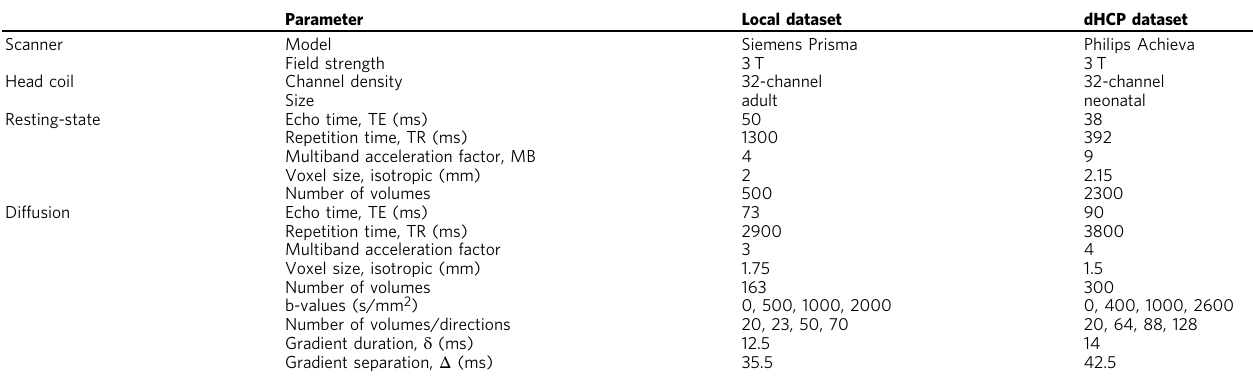
Table 3 Comparison of key data acquisition parameters between the noxious stimulation paradigm (local) dataset and dHCP dataset for resting-state fMRI and dMRI